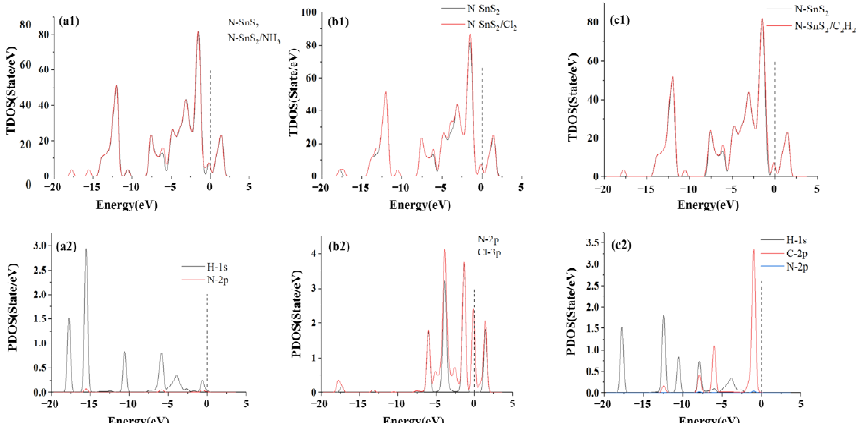
Figure 7. ( a1 ) TDOS of N-SnS 2 and N-SnS 2 /NH 3 , ( b1 ) TDOS of N-SnS 2 and N-SnS 2 /Cl 2 , ( c1 ) TDOS of N-SnS 2 and N-SnS 2 /C 2 H 2 , ( a2 ) PDOS of N-SnS 2 /NH 3 , ( b2 ) PDOS of N-SnS 2 /Cl 2 , ( c2 ) PDOS of N-SnS 2 /C 2 H 2 .